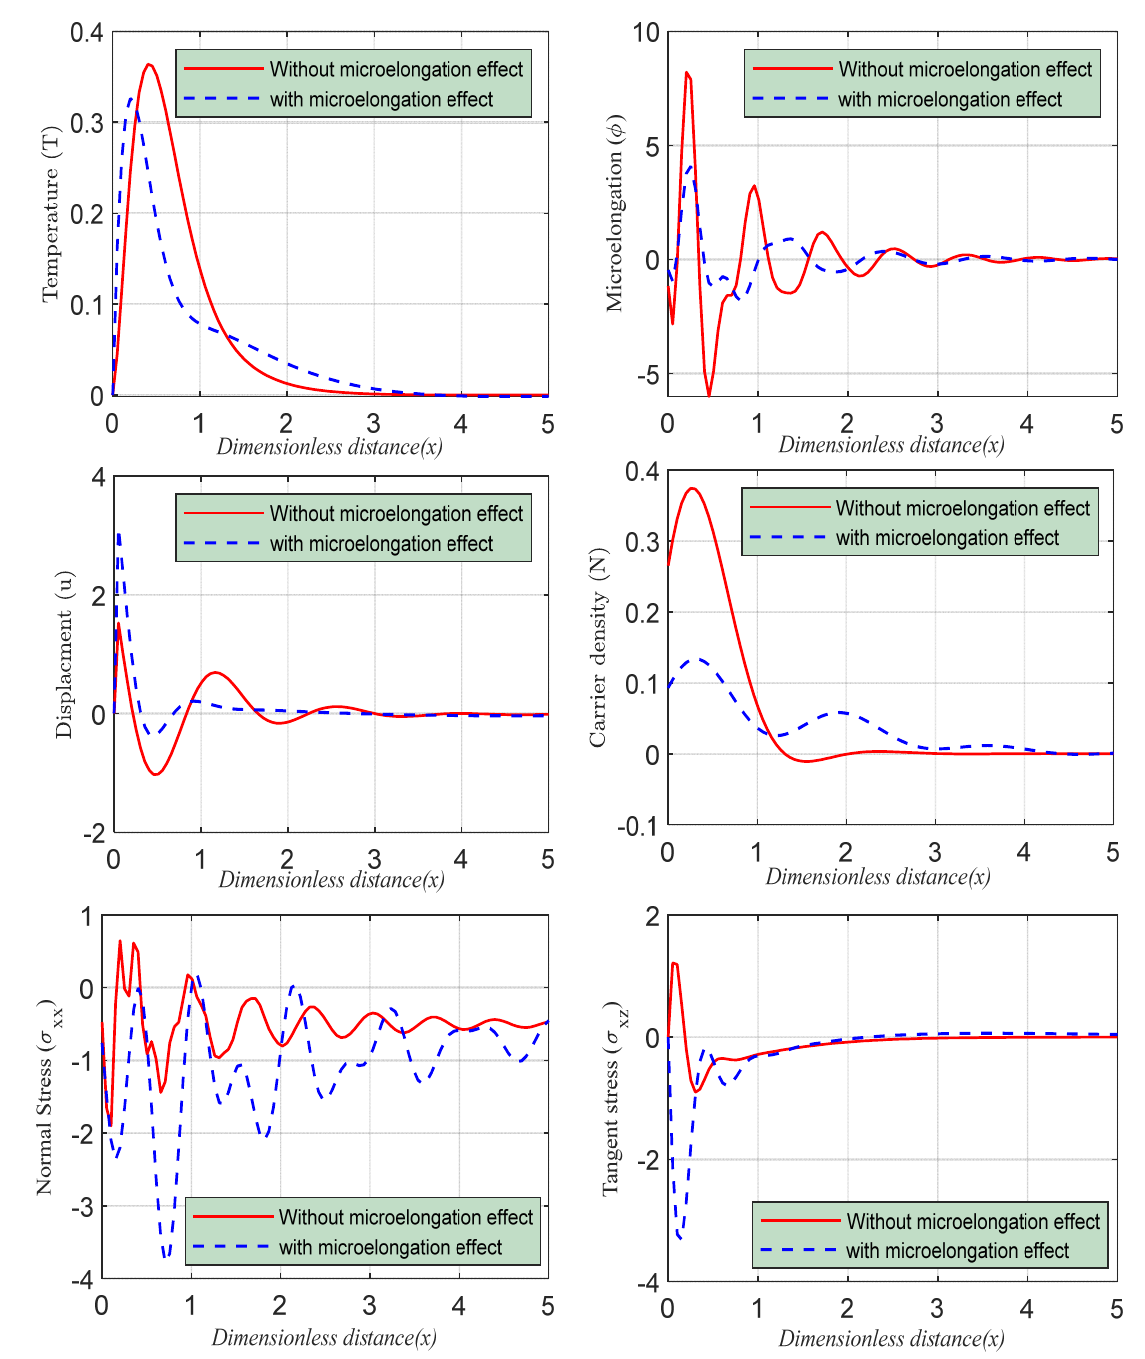
Figure 3. The wave propagations of the physical fields with the horizontal axial according to GL with magnetic field in the presence of the microelongation parameters and without the microelongation parameters.